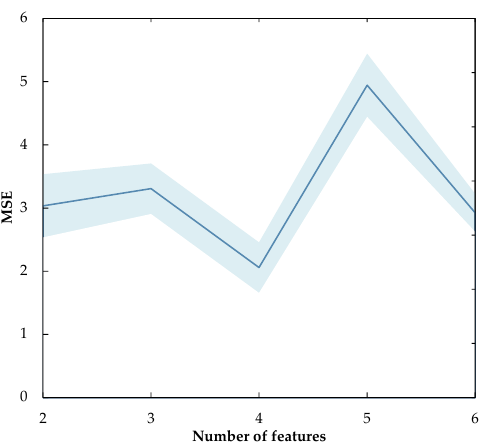
Figure 5. Mean squared error (MSE) for different number of features.